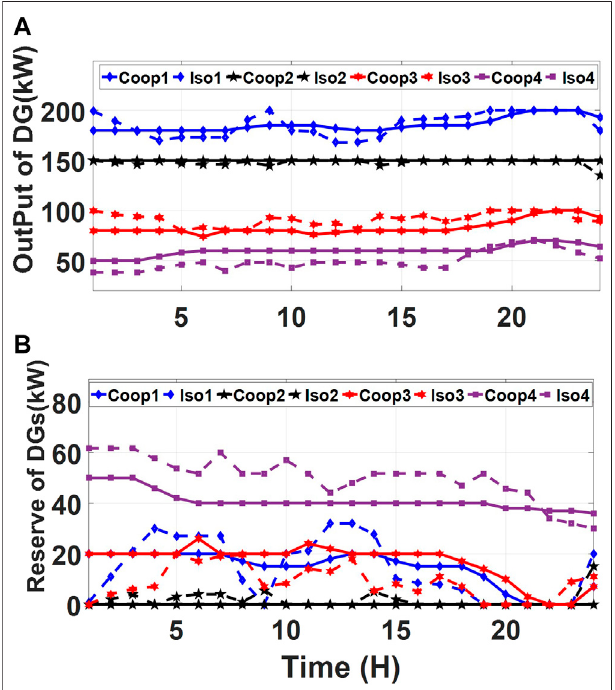
FIGURE 12 | Bene fi ts of Coalitional operation of MGs-Cluster.